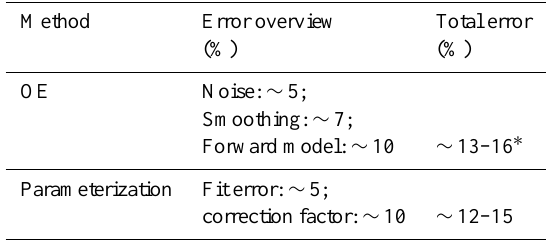
Figure 7. Azimuthal diurnal variation of (a) correction factors ( f c ), (b) differential effective path length ( L eff , see Eq. 7), and (c) NO 2 near-surface VMRs at 360, 450, and 560nm (left to right). The radii represent the local time, and the color scale the magnitude of the f c , L eff , and NO 2 VMR, using the same color scale at the three wavelengths. Table 6. Overview of the most important errors in the determination of NO 2 VMR in both the OE and parameterization